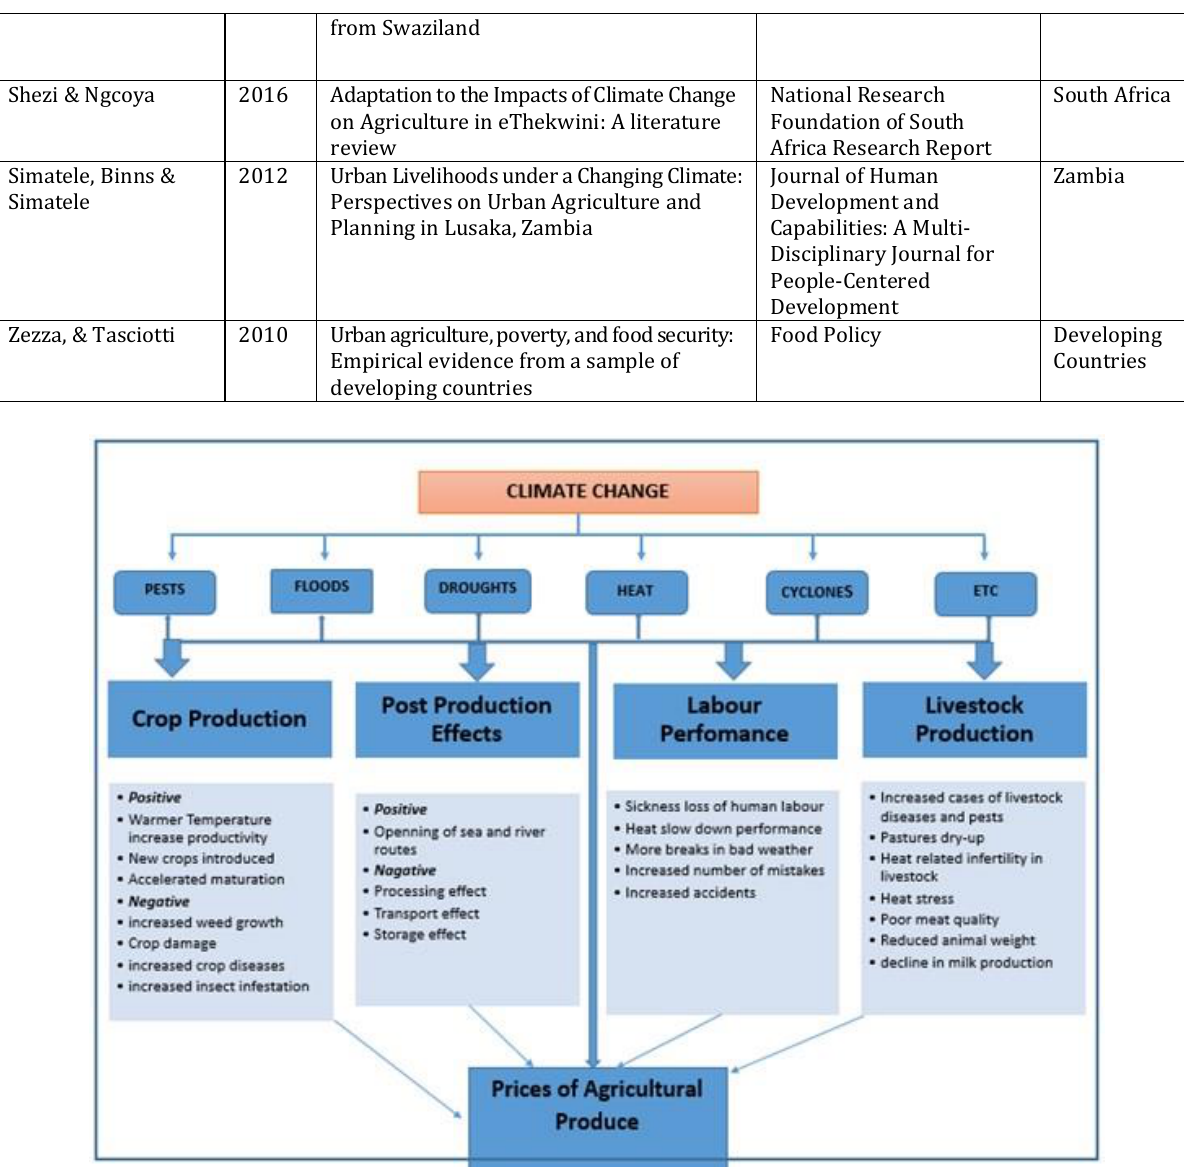
Fig. 3. A schematic presentation of the effects of climate change on (peri-) urban agriculture in sub-Saharan Africa 4.3.1. Effects of climate change on crop